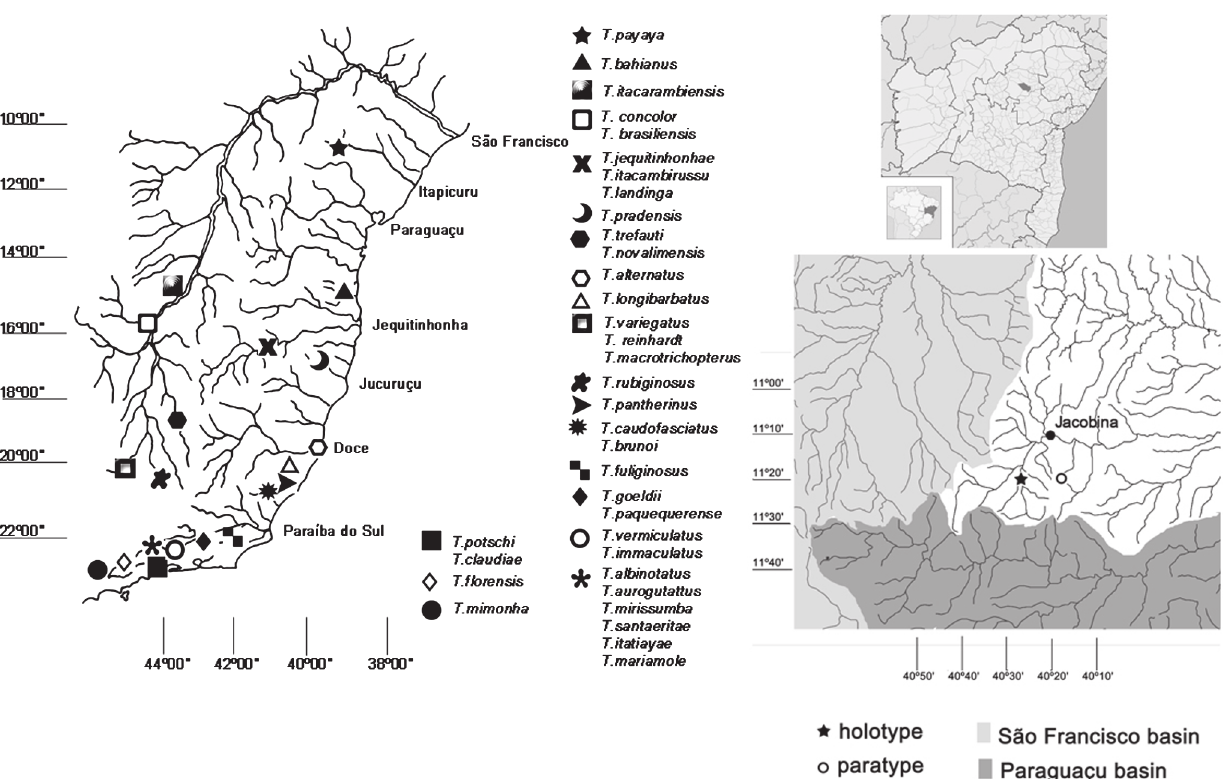
Fig. 8. Eastern Brazilian drainages between rio São Francisco and rio Paraíba do Sul, illustrating the distribution of the Trichomycterus species in the area, location of Miguel Calmon Municipality in Bahia State and in Brazil, and details of collecting localities of Trichomycterus payaya in the rio Itapicuru drainage, and neighbor river